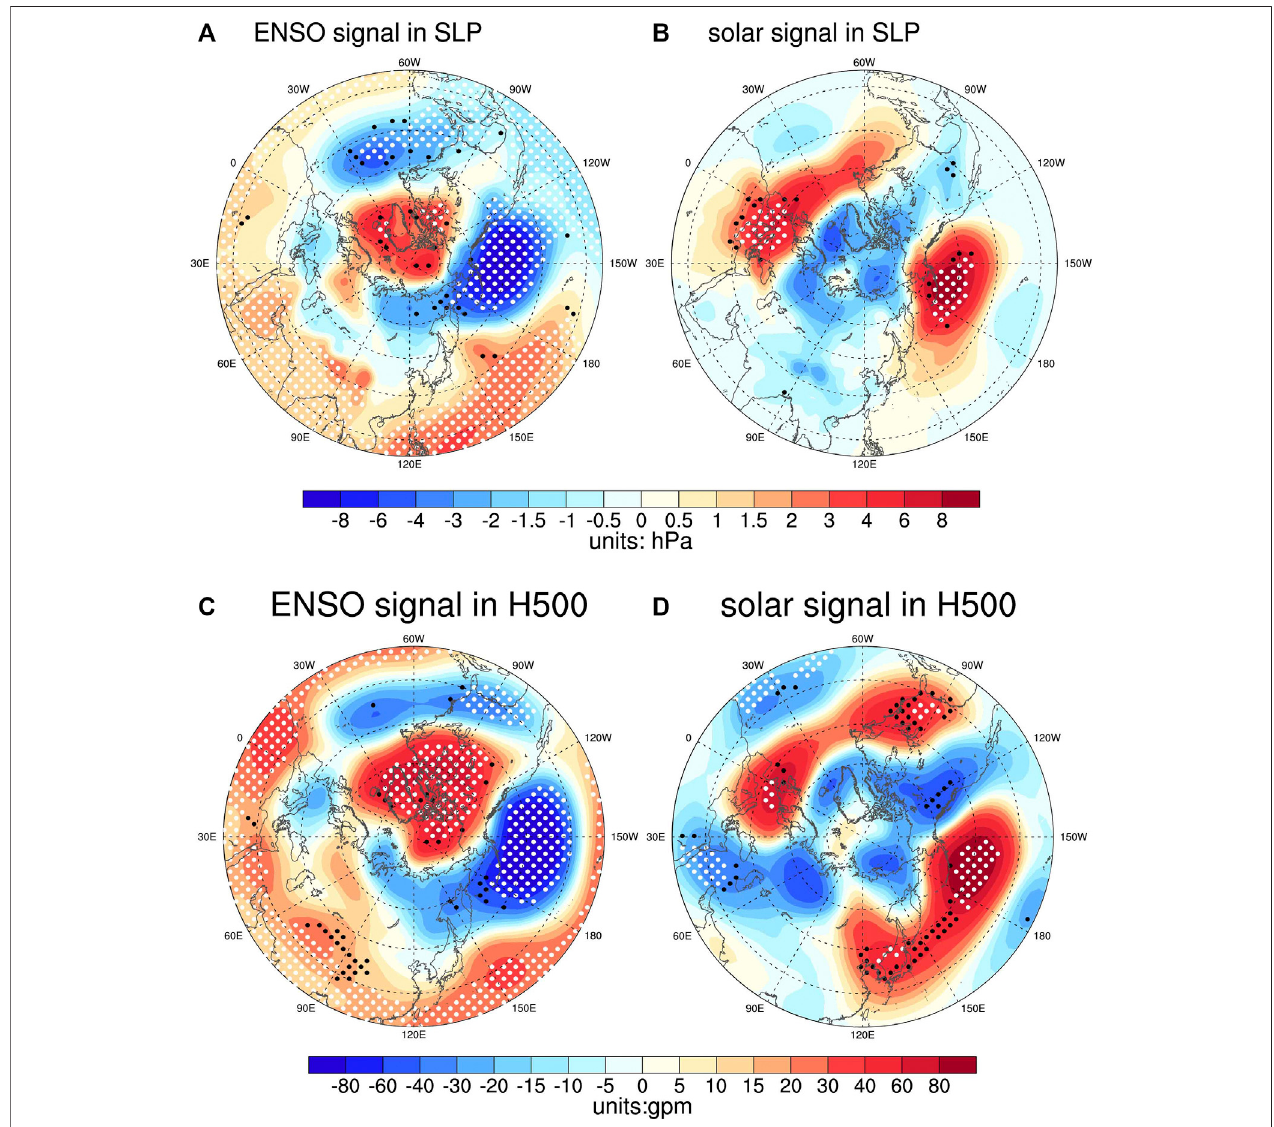
FIGURE 3 | Same as Figures 2A,B , but for the estimated ENSO and solar signals in SLP [panels (A) , (B) , unit:hPa], and 500 hPa geopotential height [panels (C) , (D) , unit: gpm]. Solid black dots denote regions where the signals are statistically signi fi cant at the 5% level (i.e., p < 0.05).